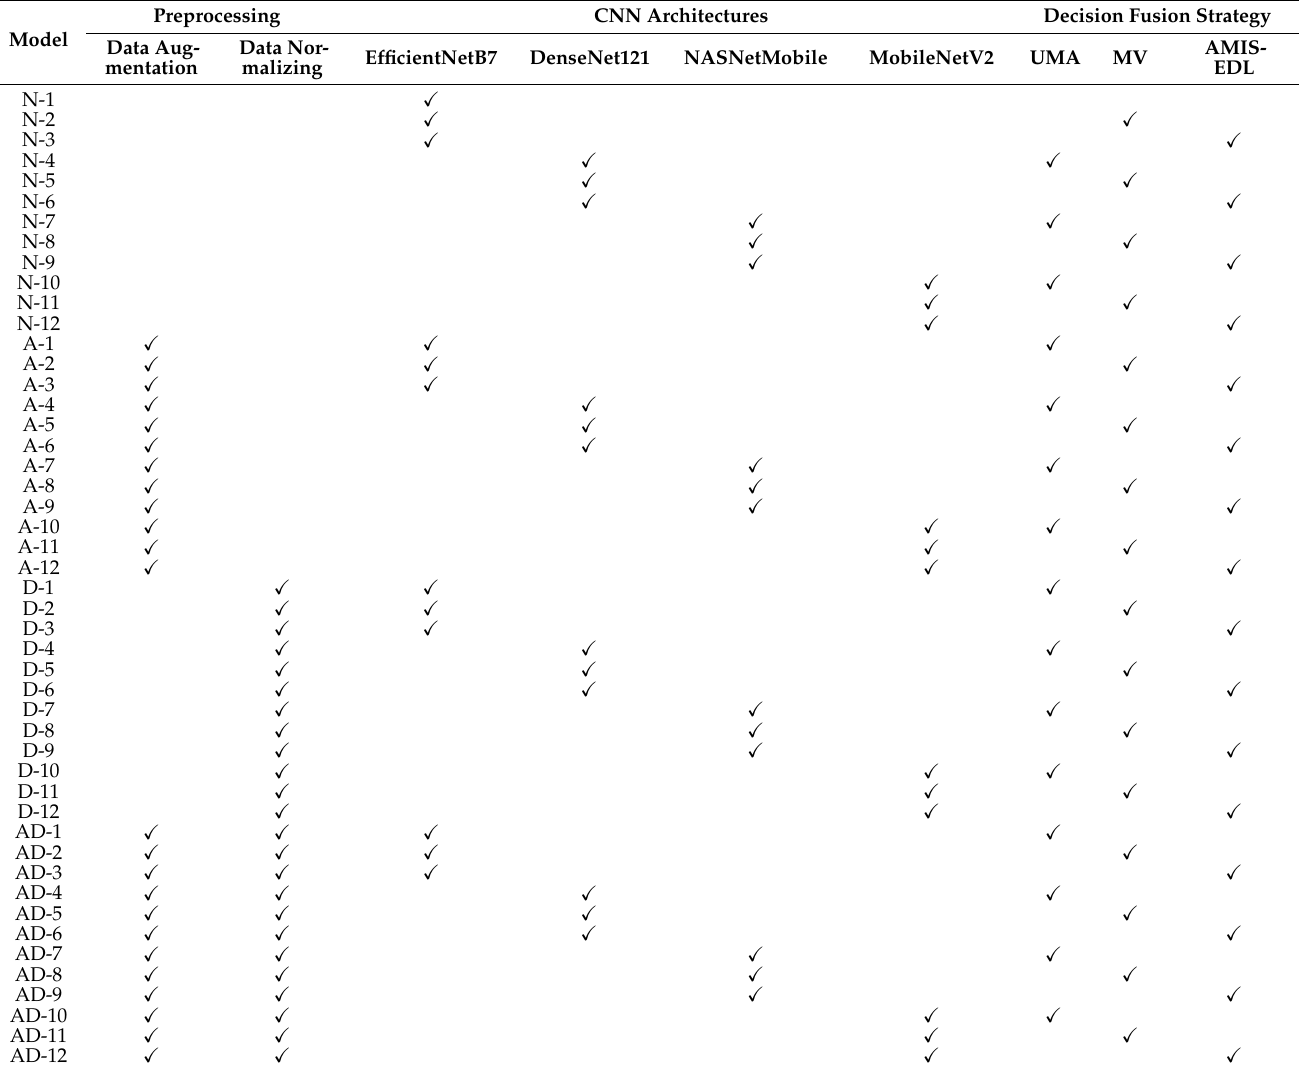
Figure 12. The framework of the proposed model used to classify the drug response of the TB patients. Table 5. Conclusions of 36 proposed models for drug response classification of TB patients.